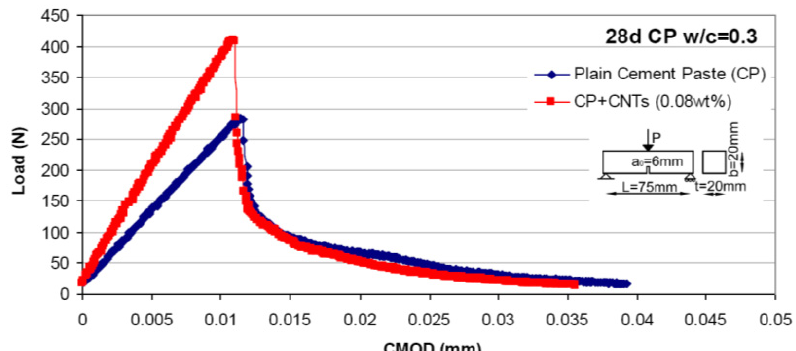
Figure 14: Flexural behaviour of cement paste with 0.08 wt% MWCNTs and plain cement paste.